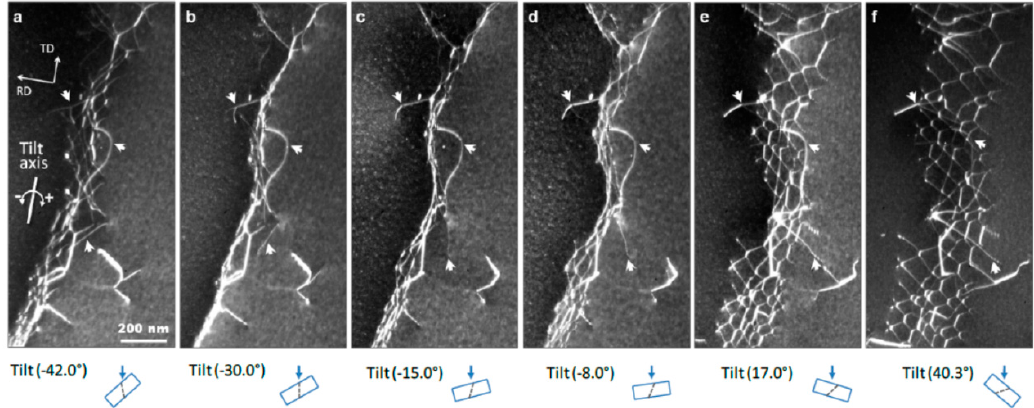
Figure 7. TEM images of a GNB observed at different tilting angles to incident electron beams. ( a – f ) show the images with tilting angles of − 42.0°, − 30°, − 15°, − 8°, 17° and 40.3°, respectively (Reprinted from Reference [77], with permission from Chuanshi Hong).